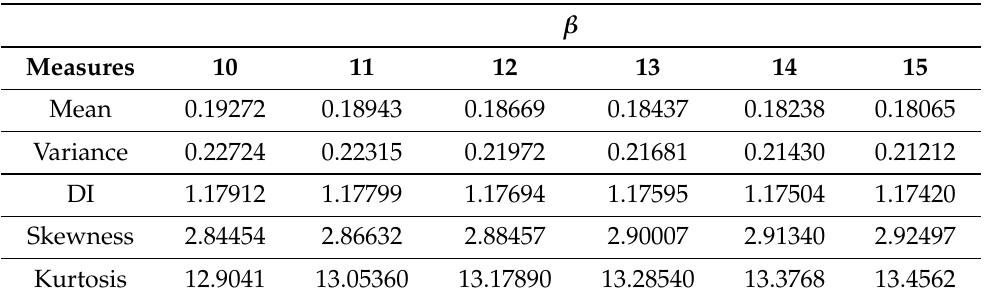
Table 2. Values for some moment measures for the DPsL distribution for θ = 2 and different values of β